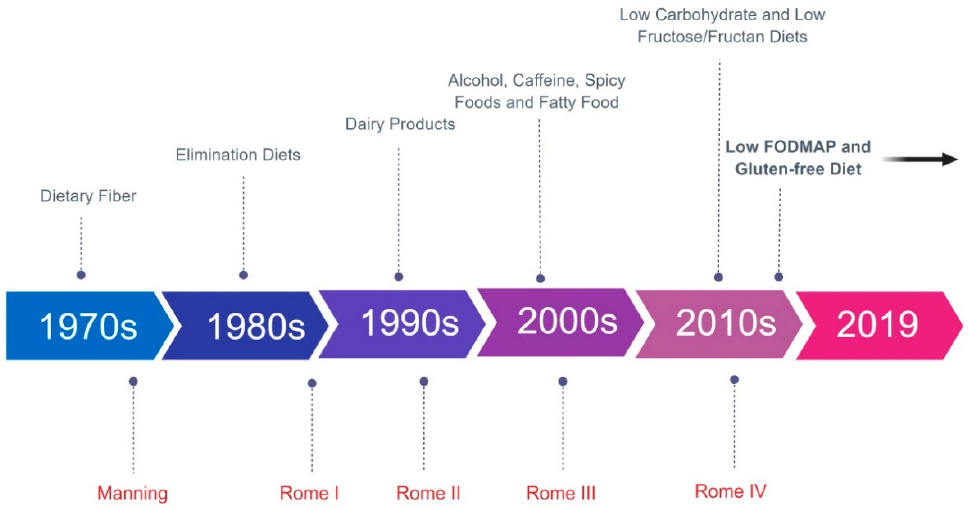
Figure 7. Timeline of dietary trials and diagnostic criteria for irritable bowel syndrome. Abbreviation: FODMAP: fermentable, oligo-, di-, monosaccharides and polyols. Created with BioRender.